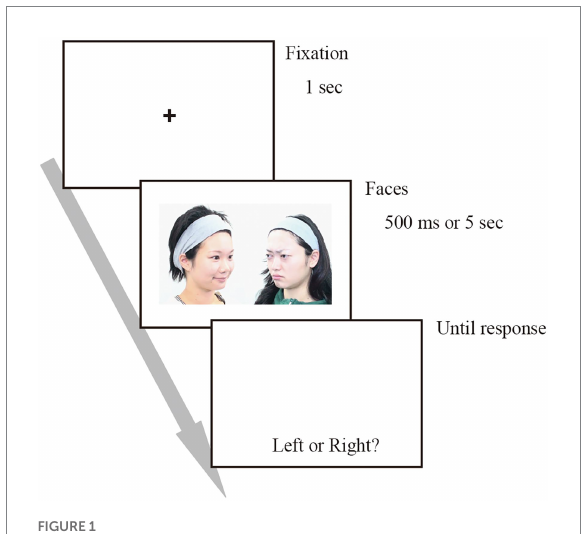
FIGURE 1 Schema for the experiments. Two individuals were facing each